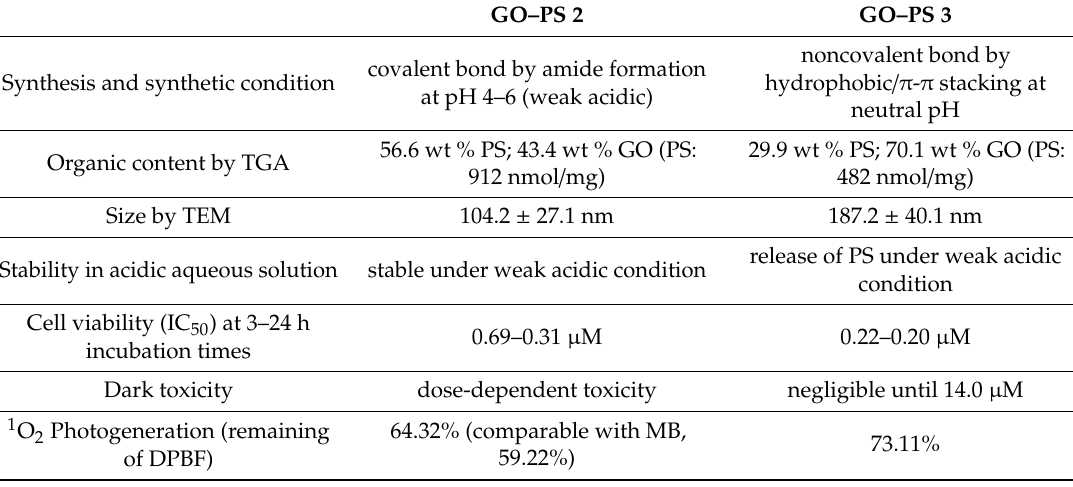
Table 3. Summary of synthesis, stability, cell viability, and dark toxicity for GO–PS 2 and GO–PS 3